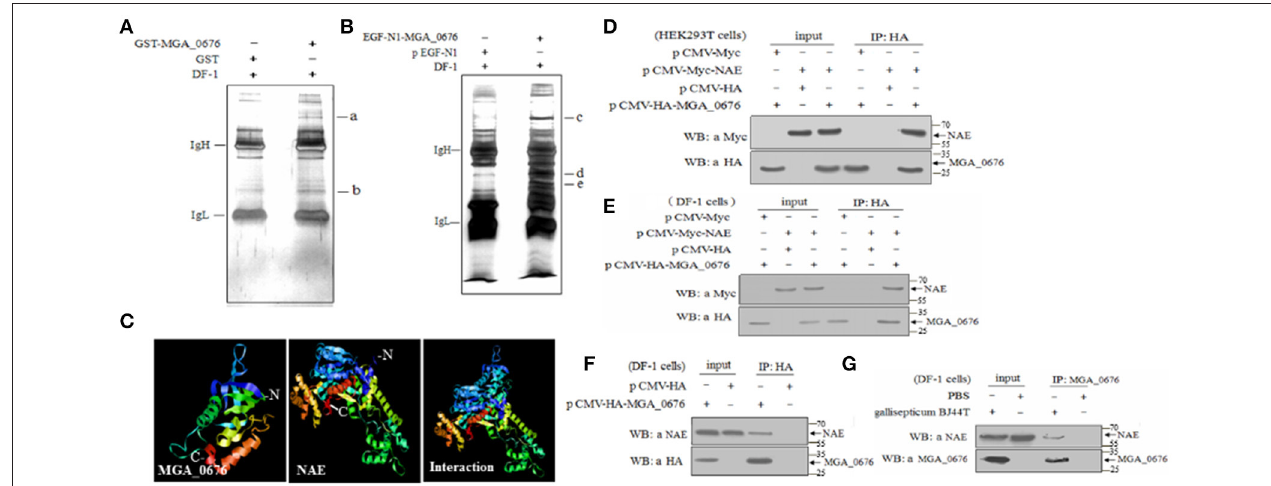
FIGURE 2 | MGA_0676 interacts with NEDD8- activating enzyme (NAE). (A) Pull down assays based on GST. IgH and IgL indicate the heavy and light chains in the antibodies; a and b show the target proteins’ interactions with MGA_0676. (B) Pull down assays based on GFP. IgH and IgL indicate the heavy and light chains in the antibodies; c, d, and e show the target proteins’ interactions with MGA_0676. (C) A model of MGA_0676 binding to NAE. MGA_0676 can bind NAE through an interaction between the C-terminal of MGA_0676 and the N-terminal of NAE. (D) HEK293T cells were transfected with the indicated expression plasmids. (E) DF-1 cells were transfected with the indicated expression plasmids. Cell lysates were immunoprecipitated (IP) with anti-HA antibody and immunoblotted with anti-HA or anti-Myc antibodies. (F) Interaction of MGA_0676 with endogenous NAE. IP of cell lysates with anti-HA antibody, and immunoblotted with anti-HA or anti-NAE antibodies. (G) Interaction of M. gallisepticum MGA_0676 with endogenous NAE. DF-1 cells were infected with M. gallisepticum or PBS as a control. IP with anti-MGA_0676 antibody and immunoblotted with anti-MGA_0676 or anti-NAE antibodies.